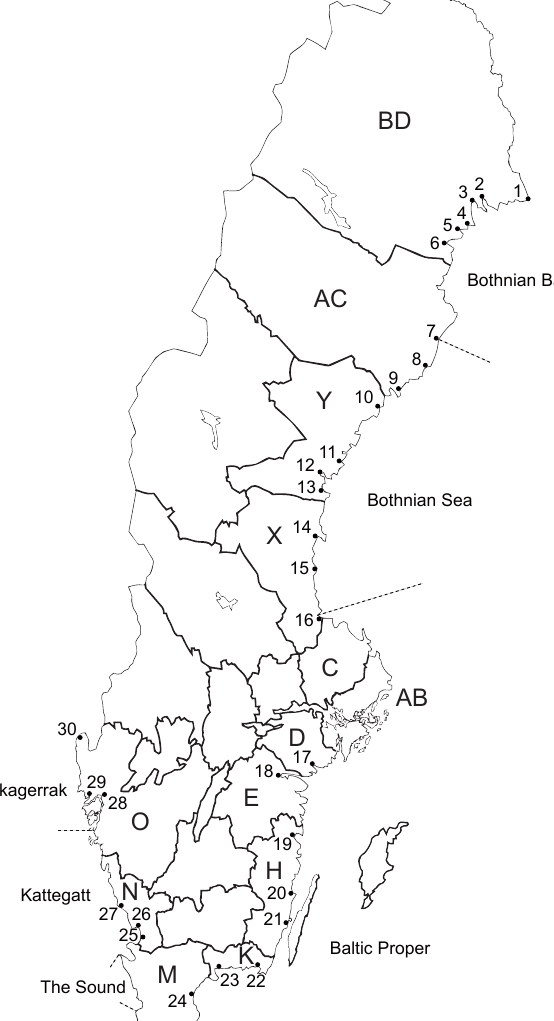
Fig. 1. Map of Sweden with the rivers denoted by numbers. Letters denote